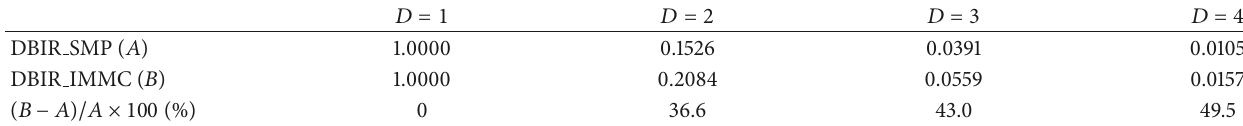
Table 2: Registration cost and its difference ratio ( 𝑇 𝑚 ∼ Gamma(1/2, 2)).